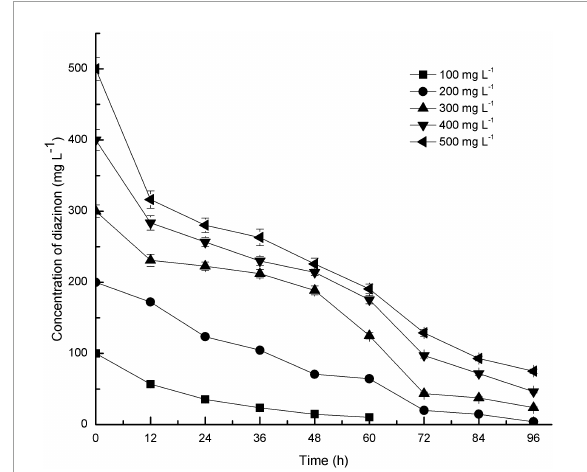
FIGURE2 Growth of bacterial isolate (DI-6) and degradation of diazinon. Diazinon concentration and DI-6 cell growth in mineral salts medium (MSM) supplemented with 100 mg L - 1 diazinon at 30 ◦ C ( (cid:110) , diazinon concentration; (cid:115) , cell growth). The data are represented as the mean and standard deviation for triplicate incubations.